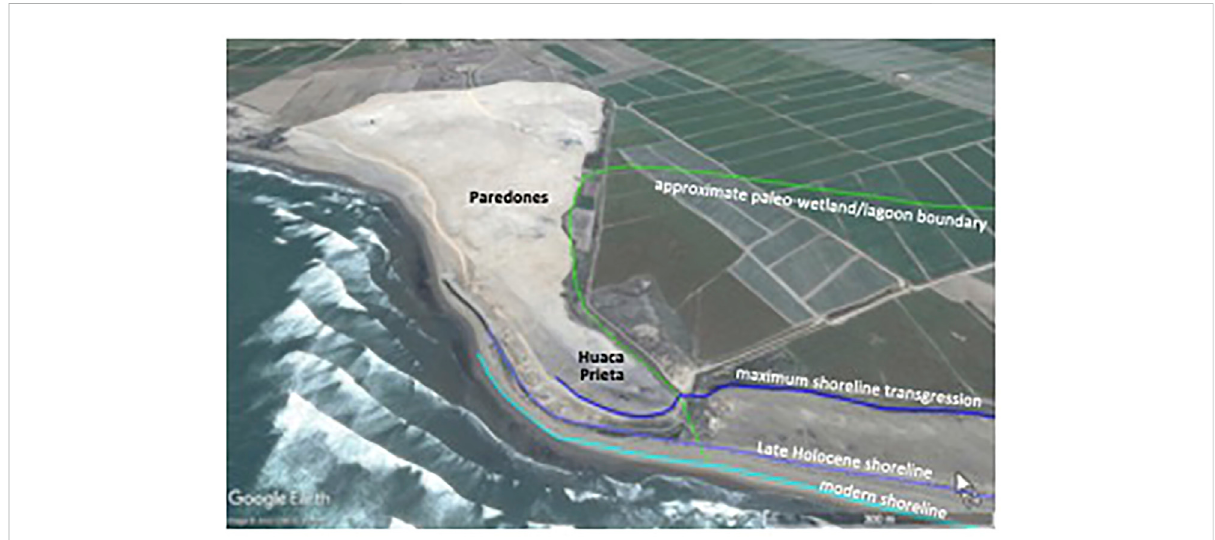
Annotated Google Earth ® image of the coastal system adjacent to Huaca Prieta and Paredones and extended to the Chicama River mouth. Stratigraphy of the coastal succession shows that the inland dunes lie on the gravel shoreface berm at the ~3,700 BP maximum transgression (dark blueline),atwhichtimetheshorelinewouldhavebeenatthebaseoftheHuacaPrietamound.Thisisconsistentwithintercalatedbeachdepositsand moundcolluviumasthebaseofthemounddatedtothistime.Followingmaximumtransgression,theshorelineprogradedtothelateHolocene shoreface (purple line), before a relative sea-level fall between 0.5 and 1 ka that forms a stranded shoreface and the new shoreline platform of the modern coast (aqua line). These shoreline boundaries are readily traced to the river mouth, where the stratigraphy is well exposed along the river